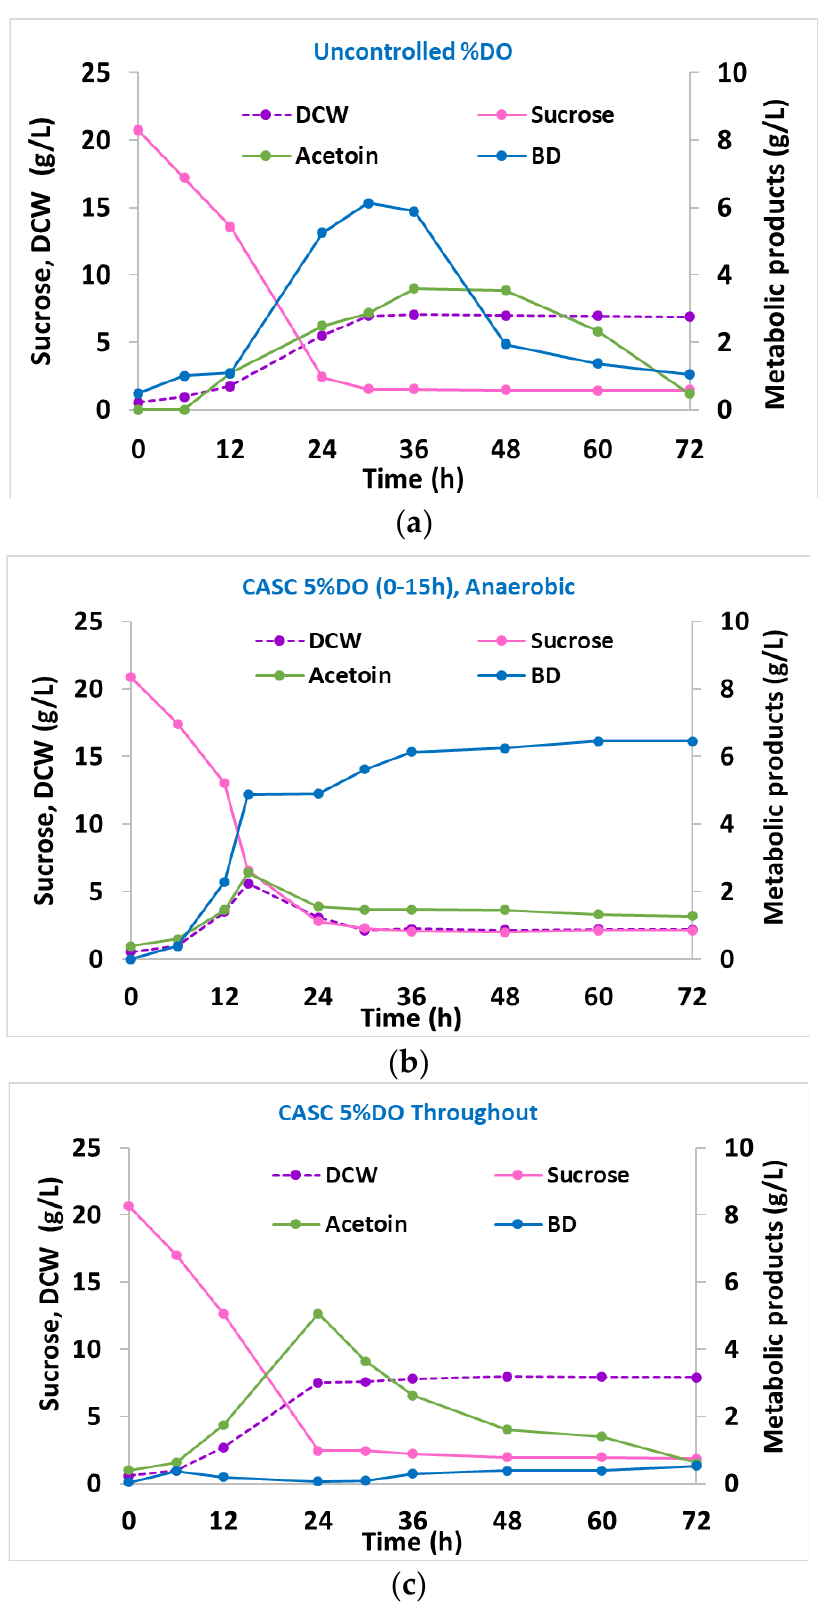
Figure 5. Metabolite production during cultivation with ( a ) uncontrolled DO, ( b ) two-stage DO regime, and ( c ) ontrolling DO at 5% throughout using B. subtilis in MMRS medium in 5 L benchtop bioreactor at 30 ◦ C, pH 6.0, agitation speed 180 rpm, aeration 1.0 vvm.